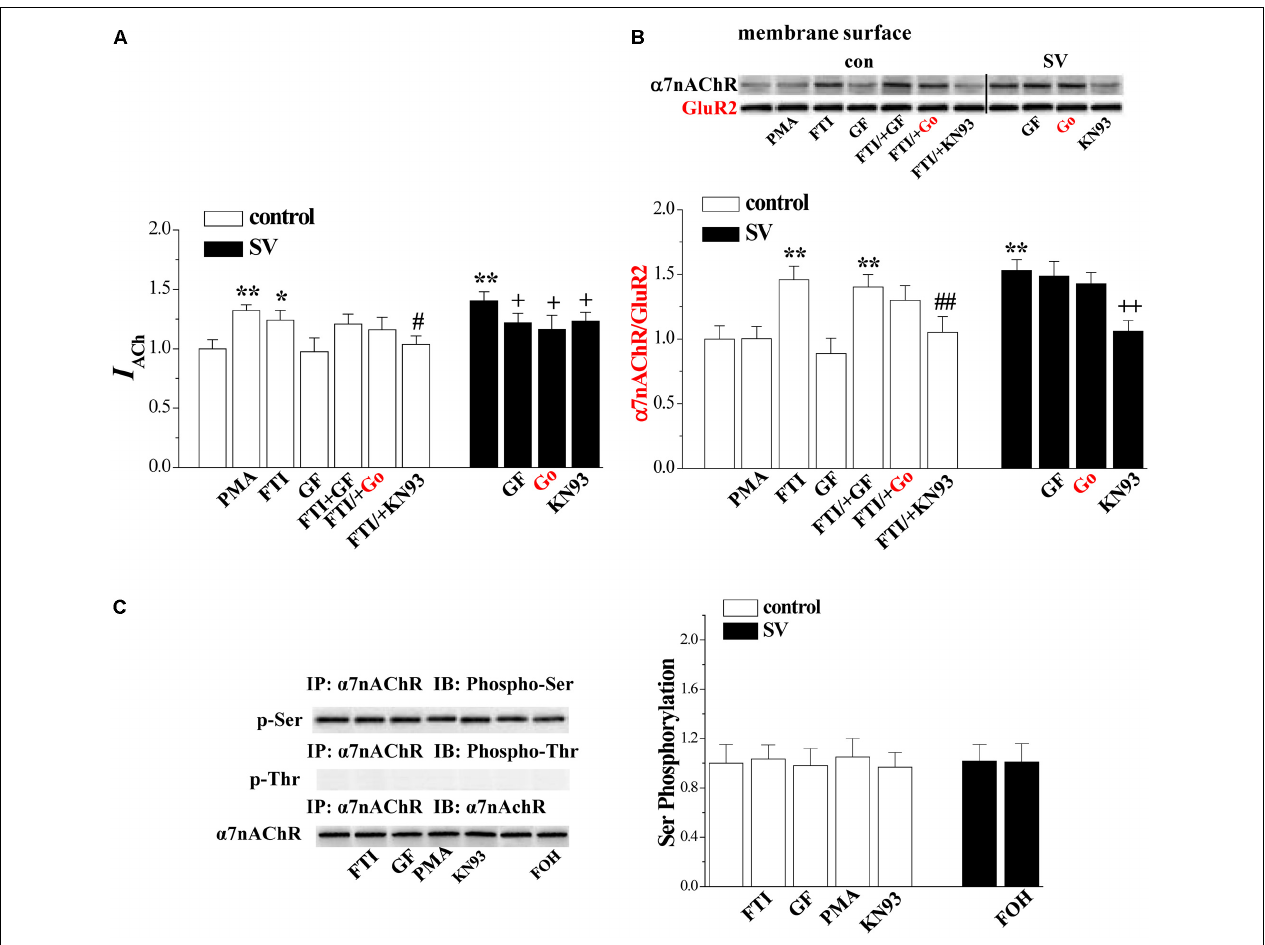
FIGURE 5 | Involvement of PKC and CaMKII signlaing pathways in SV-enhanced α 7nAChR activity and trafficking. (A,B) Bar graphs show the amplitude of I ACh and the levels of biotinylated α 7nAChR protein in PMA-, GF- or FTI-treated slices, FTI/+GF-, FTI/+Go- or FTI/+KN93-treated slices, SV/+GF-, SV/+Go- or SV/+KN93-treated slices. ∗ p < 0.05 and ∗∗ p < 0.01 vs. control slices; # p < 0.05 and ## p < 0.01 vs. FTI-treated slices; + p < 0.05 and ++ p < 0.01 vs. SV-treated slices (two-way ANOVA). (C) Bars indicate the levels of phospho- α 7nAChR in FTI-, GF-, PMA- or KN93-treated slices, SV/+FOH-treated